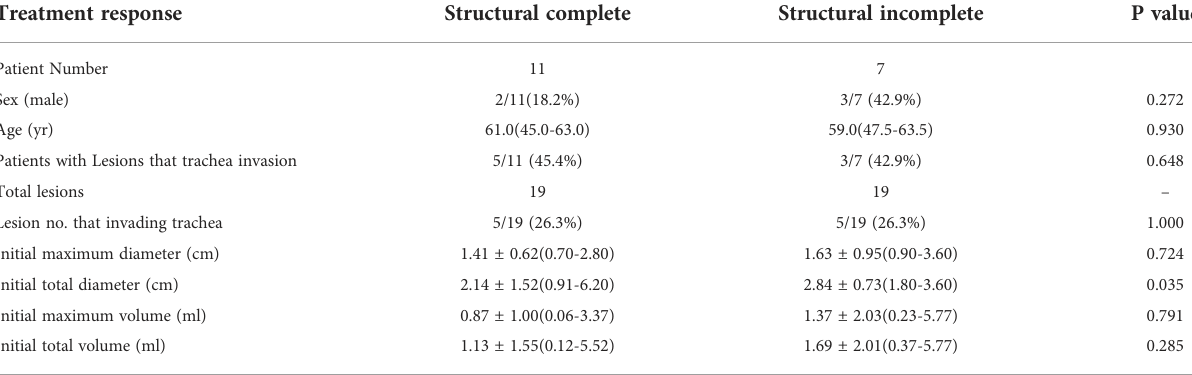
TABLE 3 In patients of pre-RFA SB(+) status (n=18), compare the group that reach structural complete and the group remained structural incomplete after RFA.